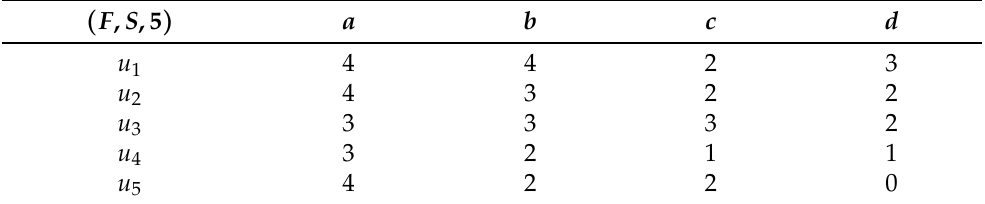
Table 8. Table 8. The 5-Soft Set of ( F , S ,5 ) . ( F , S , 5 ) a